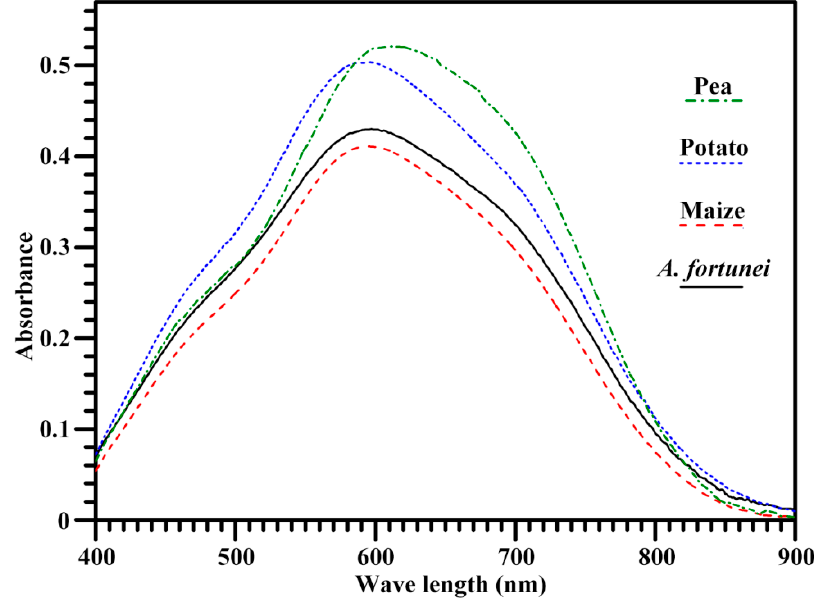
Figure 2. Spectrum of iodine absorbance of starch. Table 2. Maximum absorption wavelength ( λ max ), iodine blue value (BV), apparent amylose content (AAC), and relative crystallinity (RC) of starch.